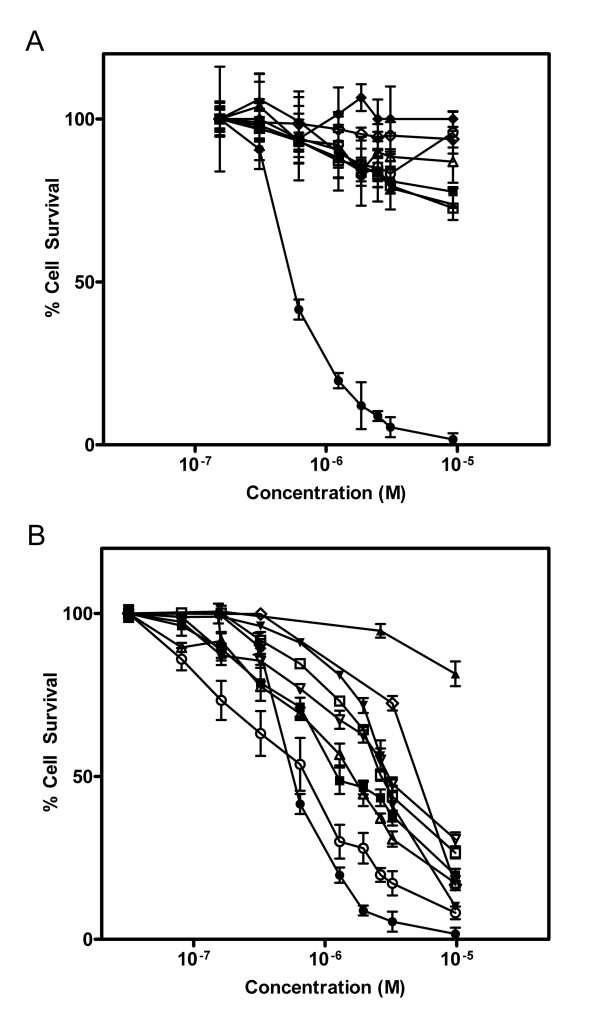
Screening of the SLT-1 A subunit library yielded a toxin variant, SLT-1AIYSNKLM, displaying cytotoxicity towards human melanoma cell lines. (A) Dose-response curves illustrating the specific cytotoxicity of SLT-1AIYSNKLM (black diamonds, black triangles, black squares, black circles) compared to wt SLT-1A (white diamonds, white triangles, white squares, white circles) for the 518-A2 human melanoma cell line (black squares, white circles). The carcinoma cell lines CAMA-1 (black diamonds, white diamonds; human breast), HepG2 (black triangles, white triangles; human liver), and PC-3 (black squares, white squares; human prostate) are insensitive to SLT-1AIYSNKLM. (B) Dose-response curves illustrating the cytotoxicity profile of SLT-1AIYSNKLM towards 8 different human melanoma cell lines: 518-A2 (black circles), A-375 (black inverted triangles), SK-Mel-28 (white circles), MeWo (black squares), A-2058 (white inverted triangles), MALME-3 M (white triangles), SK-Mel-2 (white squares), and C-32 (black triangles) as well as human melanocytes (white diamonds). Error bars represent s.e.m. for experiments performed in quadruplicate.